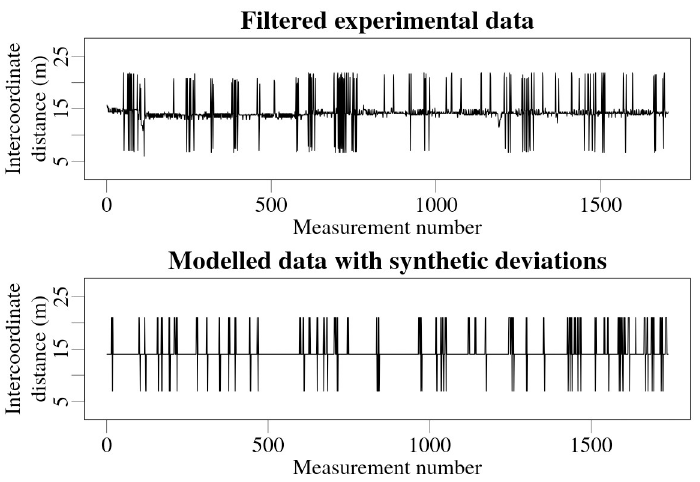
Fig 8. Filtered experimental data from experimental set-up 1 with visible deviations (top), and modeled data with simulated deviations, based on the probabilities obtained from the data above (bottom).